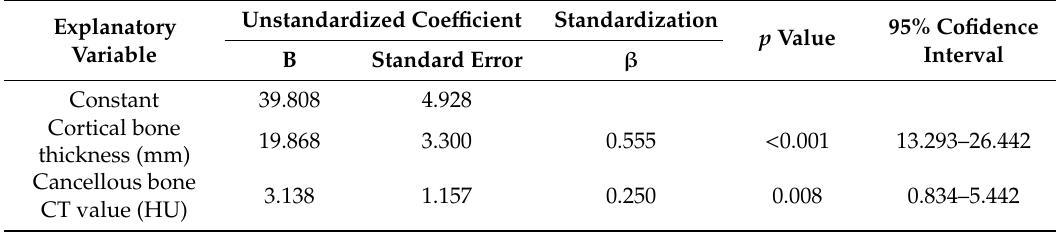
Table 4. Multiple regression analysis of the lower jaw using the ISQ value as an objective